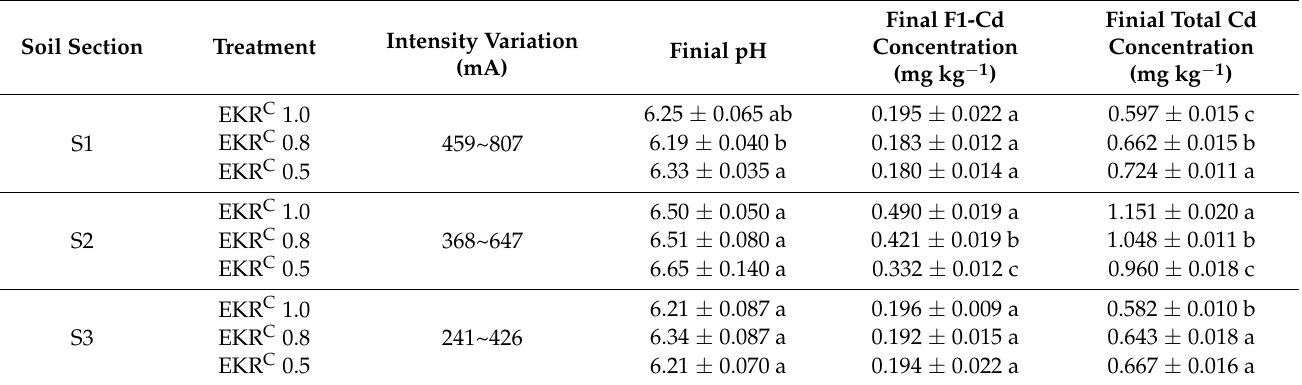
Table 2. The current intensity, soil pH, and total Cd concentration after the citric acid preacidification enhancement